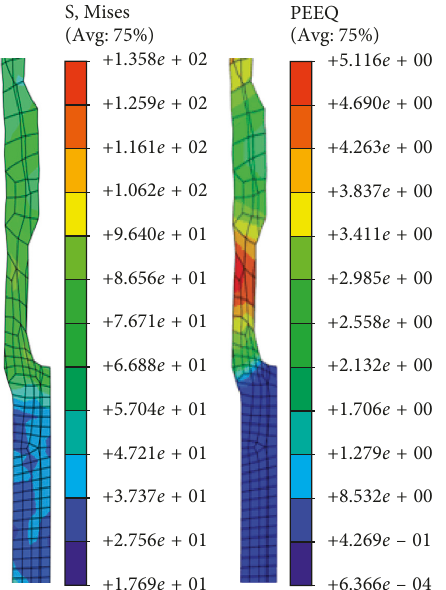
Figure 11: Mises stress diagram and equivalent strain diagram of the latitudinal ribs ( α � 20 ° , Ψ � 46%, and f � 150